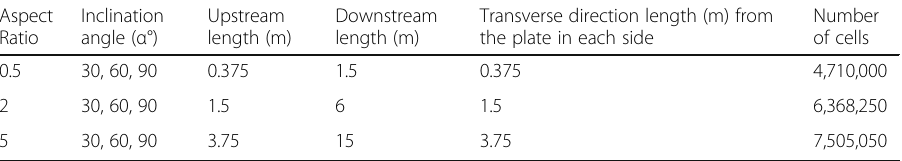
Table 3 Details of the computational domain and mesh Aspect Inclination Upstream Ratio angle ( α °) length